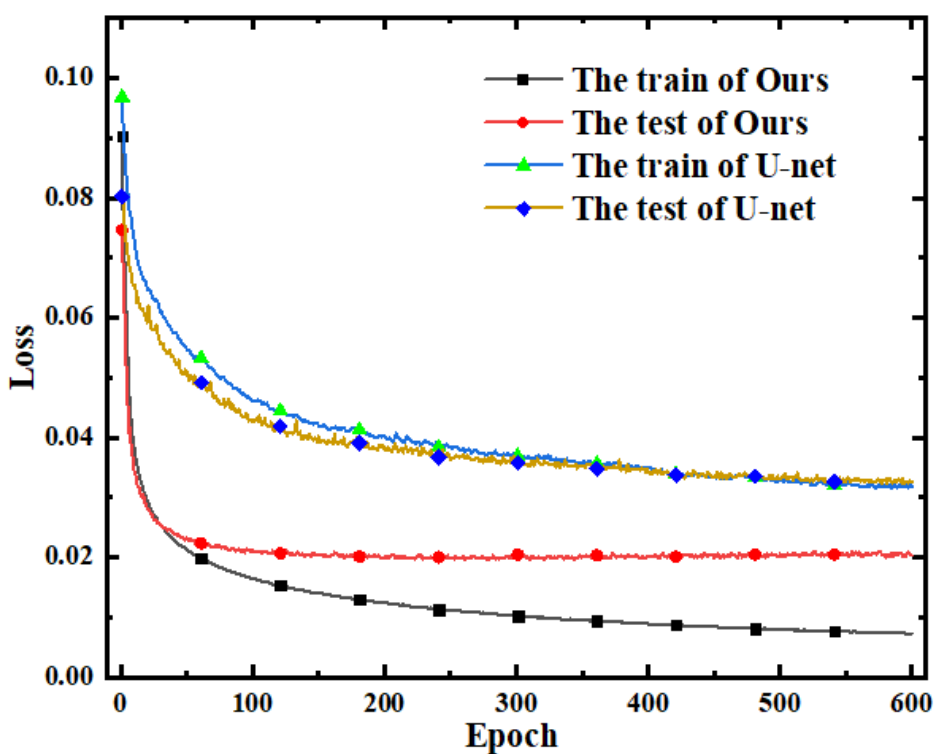
Figure 7. The loss curve comparison for U-net and MLCNN.